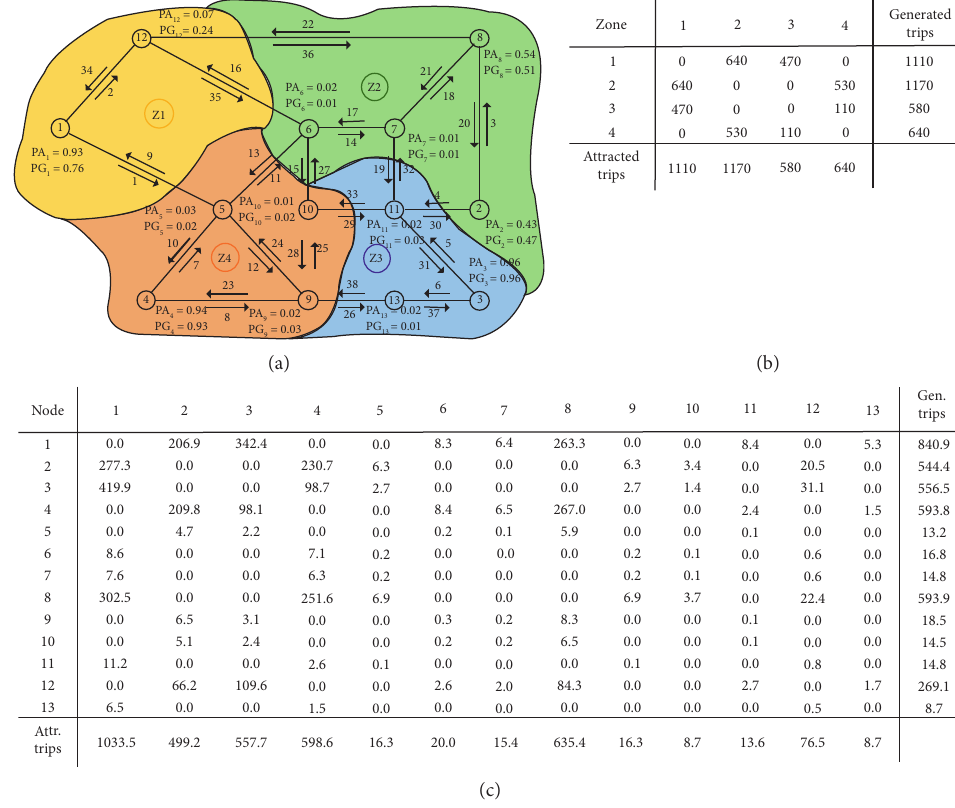
Figure 5: PA ni and PG ni proportions and the extended OD matrix for the example with the Nguyen-Dupuis